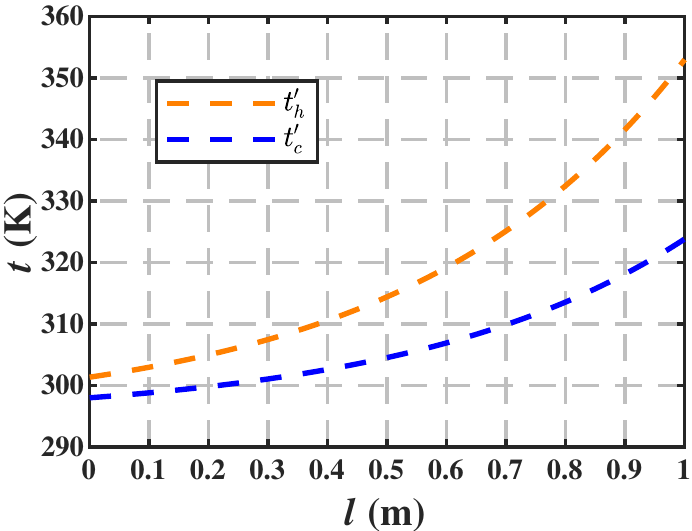
Figure 4. Temperature profiles of the above CFHX with exchanged heat capacity rates. To clarify this feature, the curves are compared in Figure 5. The inlet temperatures of the hot and cold streams are marked as A and B , respectively. Equation (13) reveals that curves AA (cid:48) and BB (cid:48)(cid:48) are rotationally symmetrical around the midpoint of AB , which is marked as o . Meanwhile, curves AA (cid:48)(cid:48) and BB (cid:48) have similar symmetry. The total amount of heat transferred in the CFHX is the product of hA and the area enclosed by the high and low temperature curves; hence, the two pairs of heat capacity rates result in the same total heat exchanged.